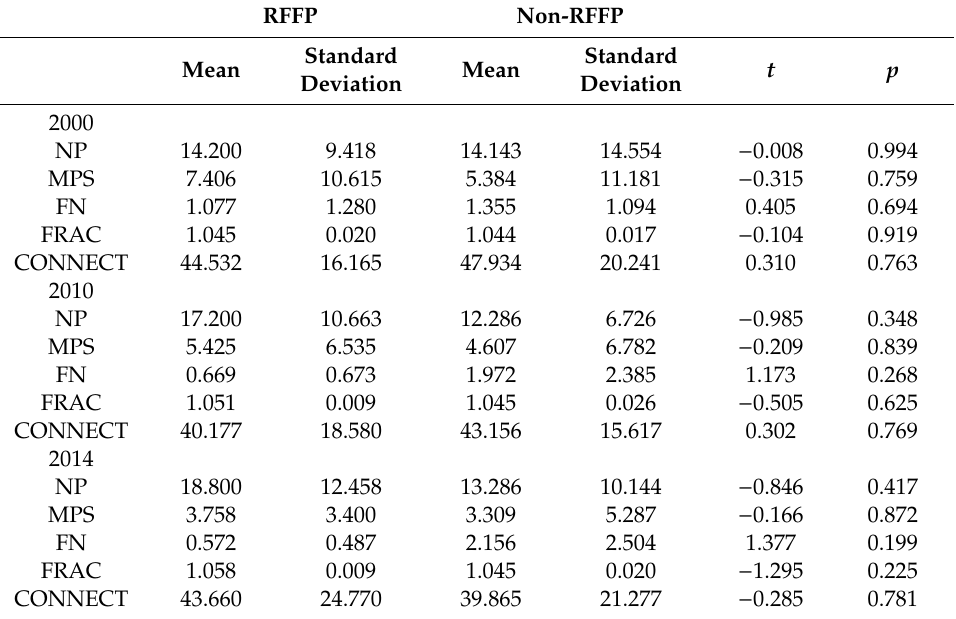
Refer to Table 3 for the abbreviations for landscape